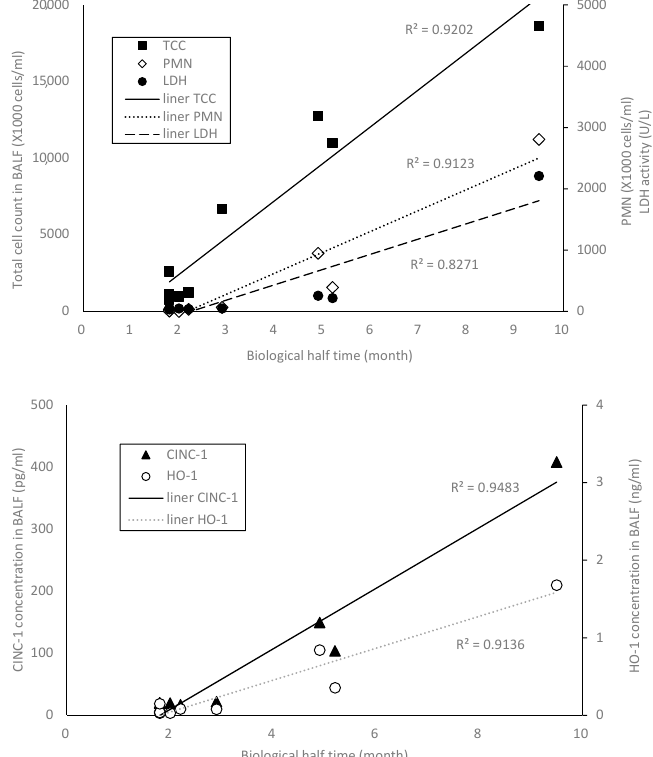
Figure 5. Relationship between biological half time and the other biomarkers. (Mean total cell count (TTC), polymorphonuclear neutrophils (PMN), lactate dehydrogenase (LDH), chemokine-induced neutrophil chemoattractant (CINC-1), and hemo oxygenase-1 (HO-1) at 1 month after the exposure).